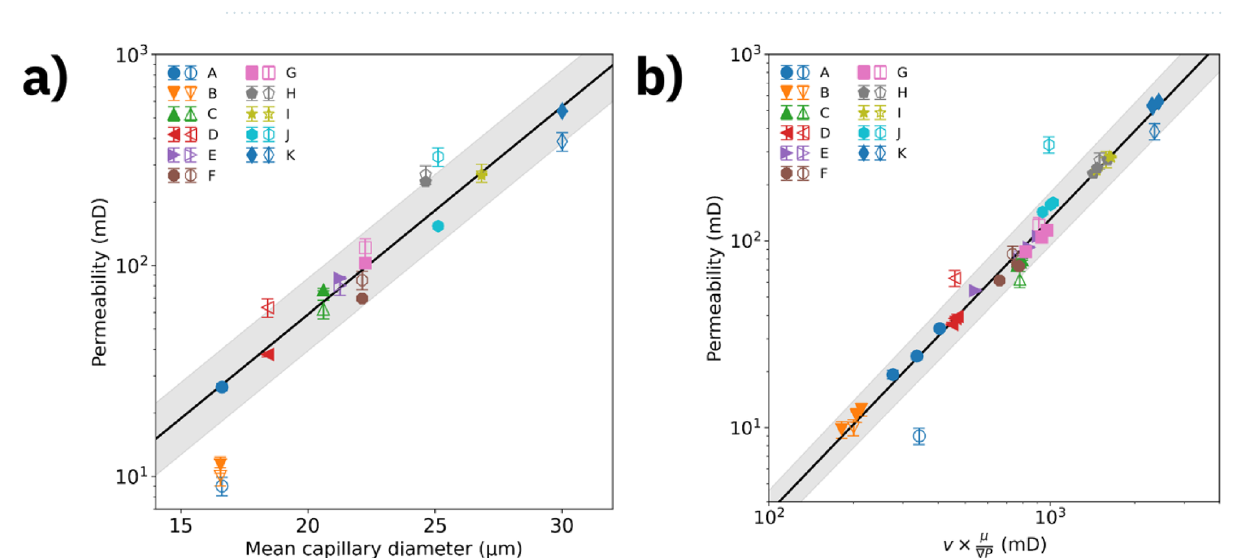
Figure 4. Scaling of permeability as function of mean capillary diameters and mean flow speeds. Computed (experimental) permeability is represented by filled (open) symbols. ( a ) Permeability as function of mean capillary diameter for all rock samples studied. ( b ) Permeability as function of volume-averaged flow speed multiplied by (µ/ ∇ P ) along all 3 axes for all rock samples studied. The plot aggregates results from simulation scenarios with viscosity µ = 1 cP and pressure gradient of 10 kPa/m, as well as variations with 10 × higher viscosity or 10 × stronger gradient, covering two orders of magnitude variation in flow speeds. The lines represent linear fits to the data and the shaded area represents the fit uncertainty. The computed data are CNM